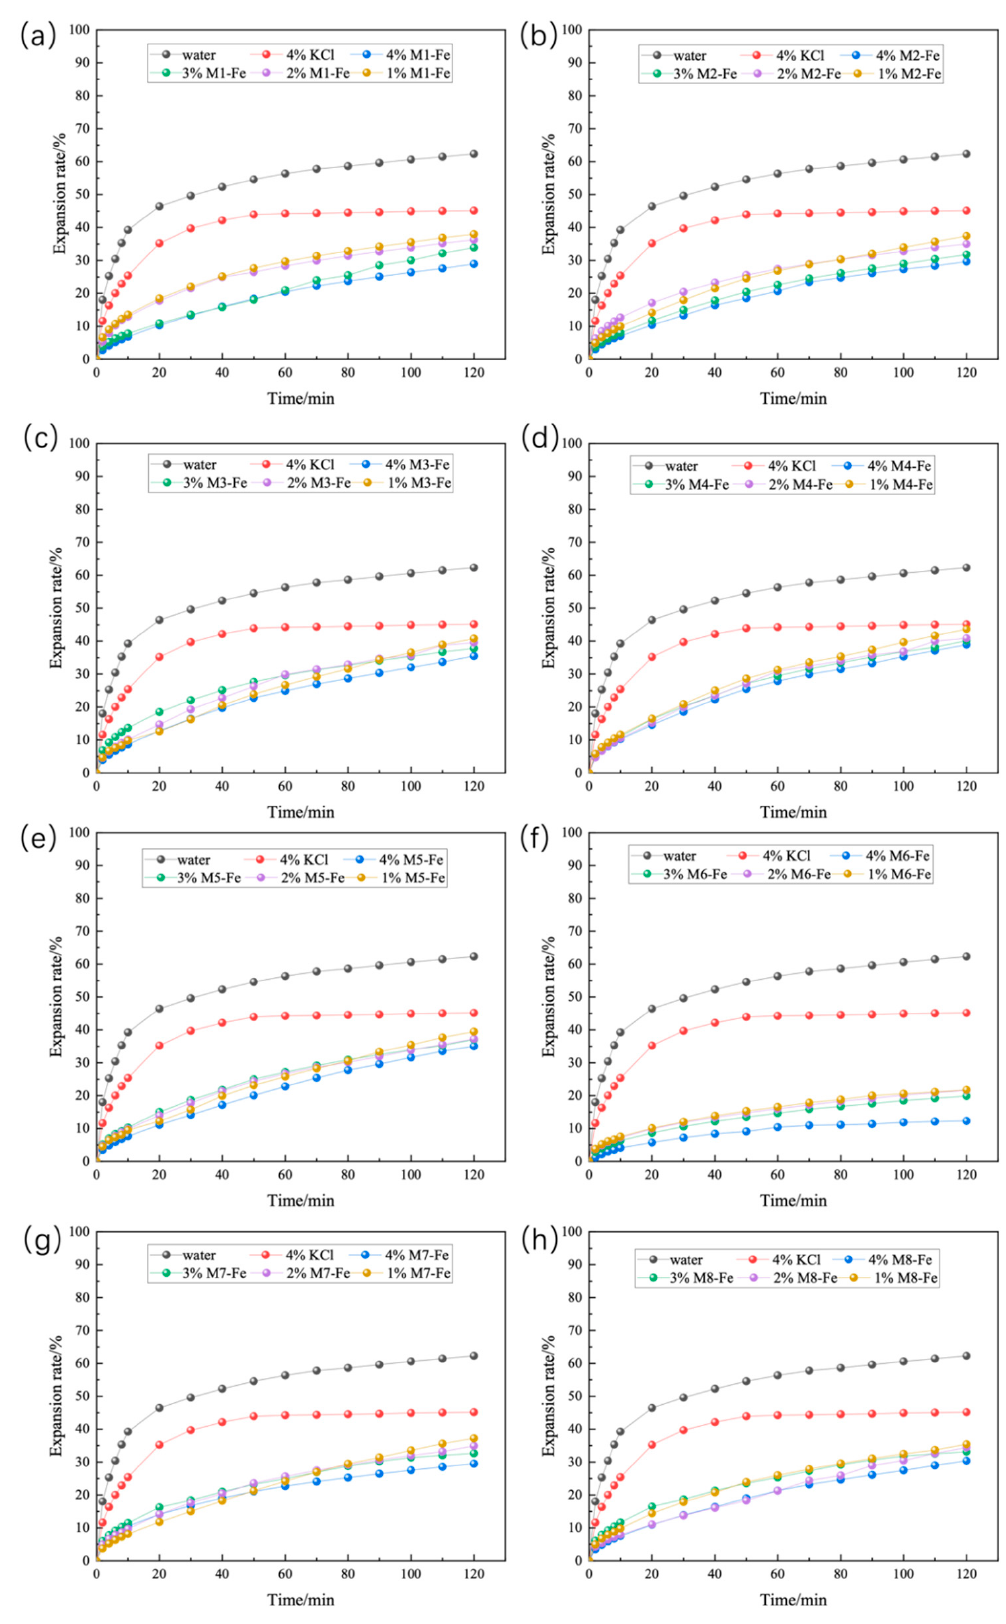
Figure 3. Linear expansion of Fe-doped MMH with different concentrations (( a ): M1-Fe; ( b ): M2-Fe; ( c ): M3-Fe; ( d ): M4-Fe; ( e ): M5-Fe; ( f ): M6-Fe; ( g ): M7-Fe; ( h ): M8-Fe).